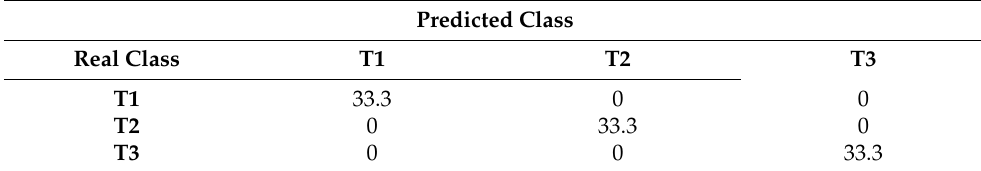
Table 4. Confusion matrix obtained through PLS-DA for discrimination between stuffed olives with Diagonal bold contains the percentage of correct assignments. T1: olives with ferrous gluconate stuffed with 0% flavoured hydrocolloids. Values are expressed in percentage. of ‘Mojo pic ó n’; T2: olives with fresh Carao stuffed with 0% of ‘Mojo pic ó n’; T3: olives with lyophilized Carao stuffed with 0% of ‘Mojo pic ó